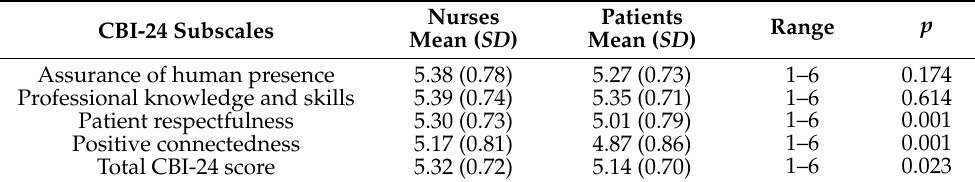
Abbreviations: SD—Standard Deviation; CBI-24—Caring Behaviors